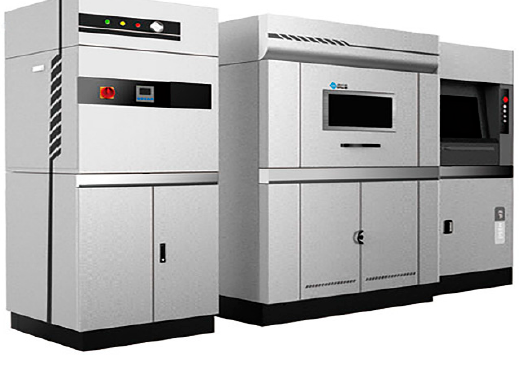
Figure 3. 3D printer EP-M250 machine.